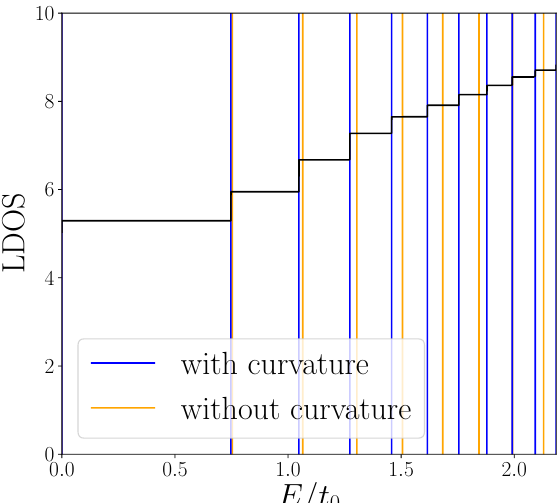
Figure 2: Tight-binding results for the strain profile (32) with TB parameter β = 3. We perform exact diagonalization (ED) of a lattice with 10,000 sites. We show the / L = 0.0105. We plot the expected position integrated LDOS for the parameter au B of the pseudo Landau levels with and without the additional contribution from